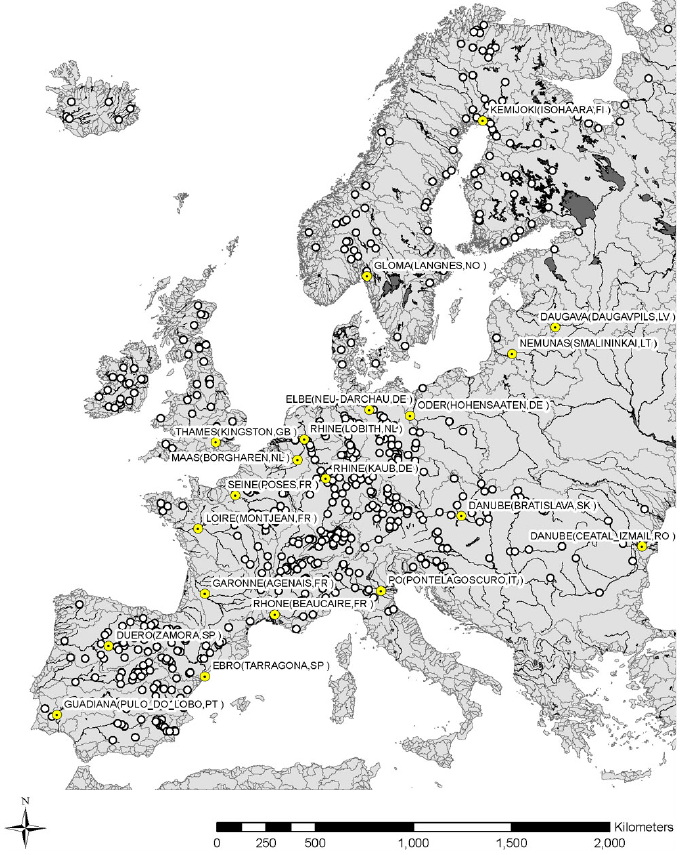
Fig. 1. Location of the 554 gauging stations used to assess simulated river discharges. These stations have at least 25yr of daily data for the control period